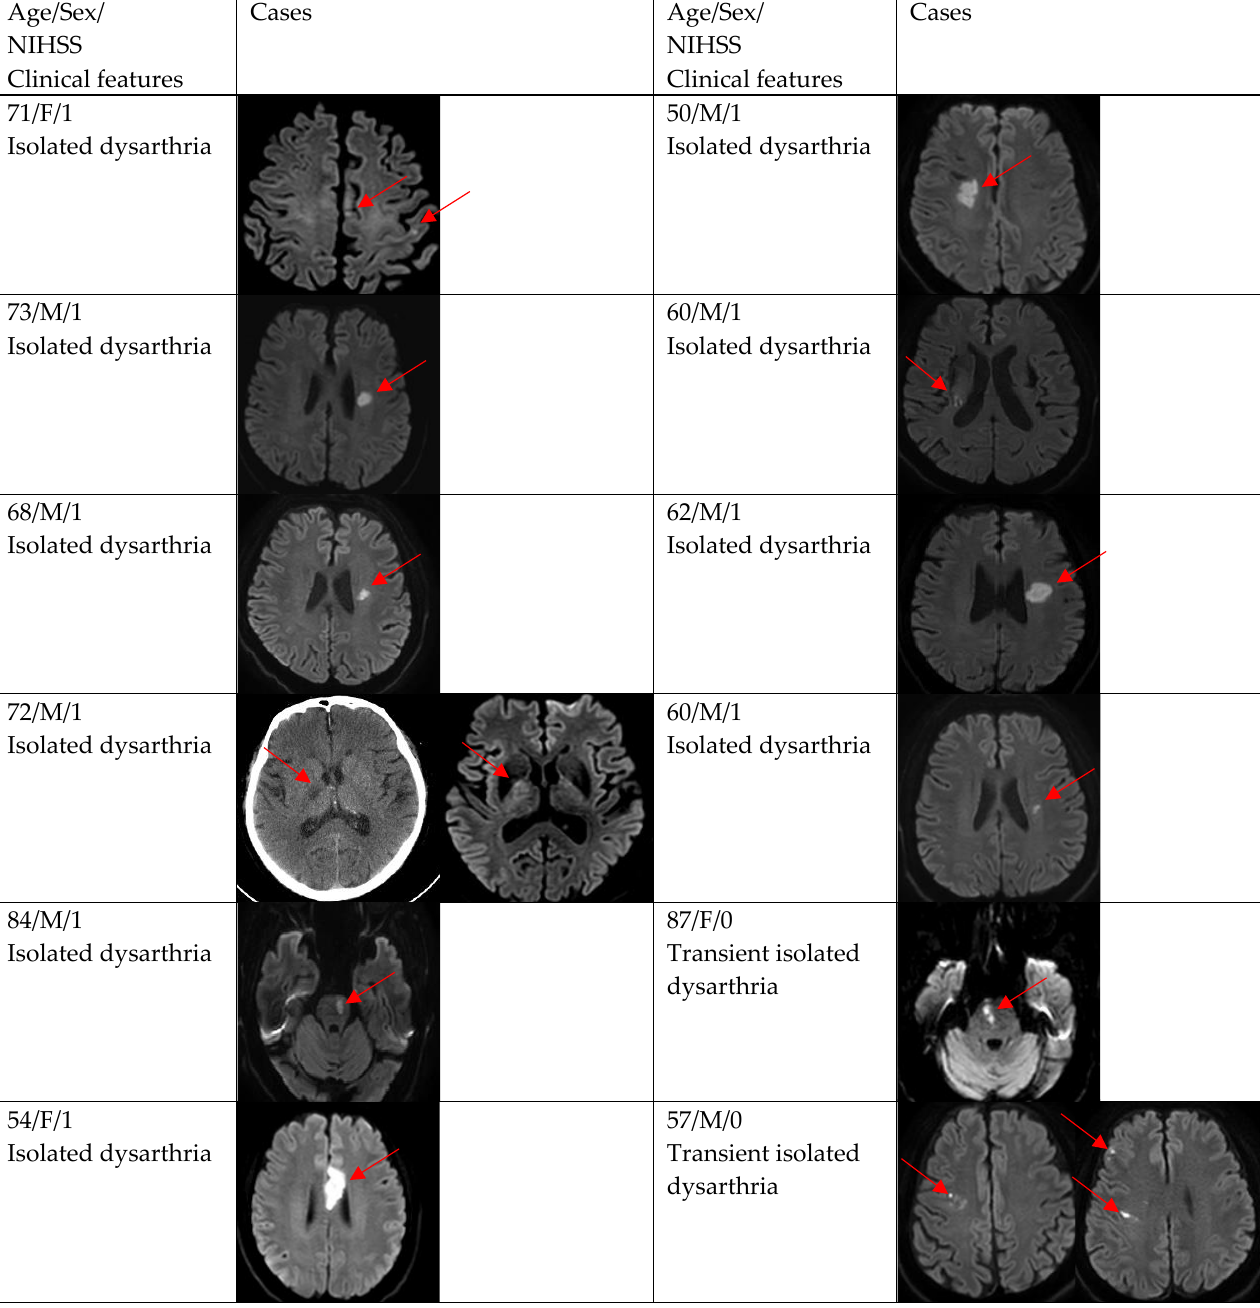
Figure 2. Clinical characteristics and neuroimaging findings of patients with ischemic stroke or TIA presenting with dysarthria only. Except for the bottom two cases, all showed a single lesion on DWI .